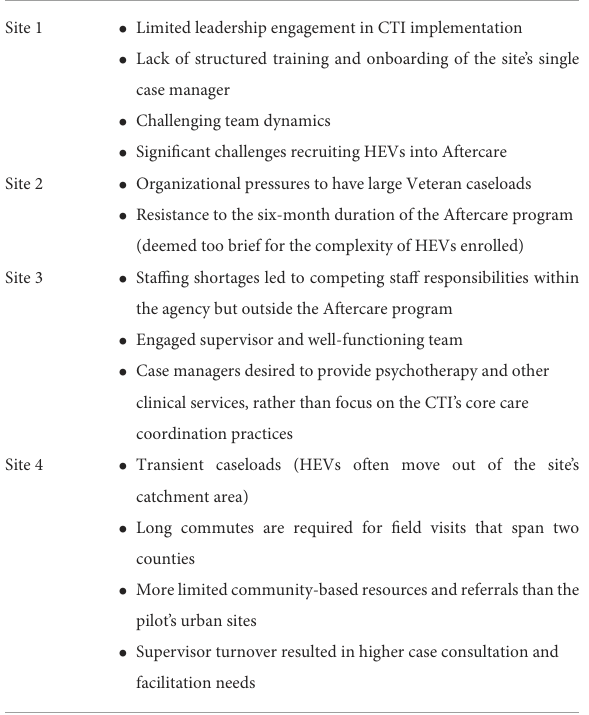
TABLE 3 Summary of contextual factors that challenged CTI implementation at each pilot